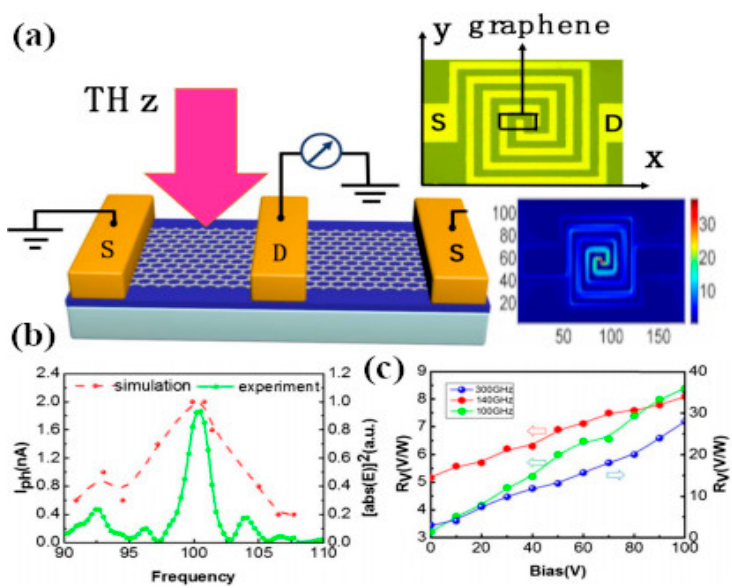
Figure 20. ( a ) Schematic of a graphene-antenna-assisted photodetector for terahertz detection at room temperature; the geometry of the proposed photodetector is comprised of three consecutive gold electrodes placed on the surface of a silicon wafer, with a graphene sheet placed between the two which acts as coupler for incoming EM energy and provides an active channel for plasmons propagation.